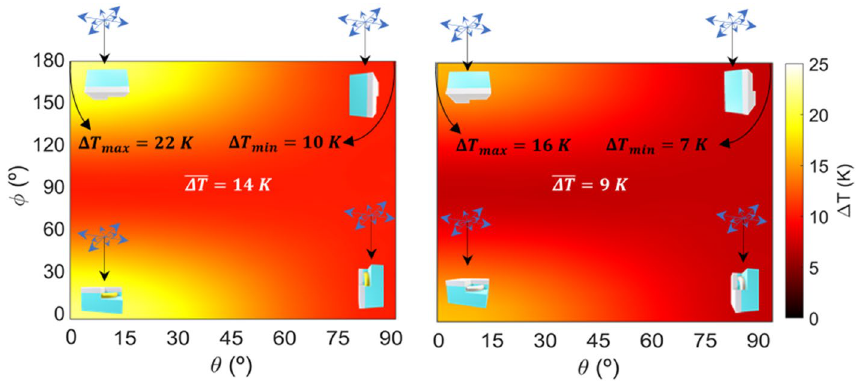
Figure 7. Thermal responses of the gold and platinum ternary nanojet to rotations. θ and ϕ are the rotations with respect to the x and y axes. The considered unpolarized light (insets) injects a power density of 0.1 mW/ μm 2